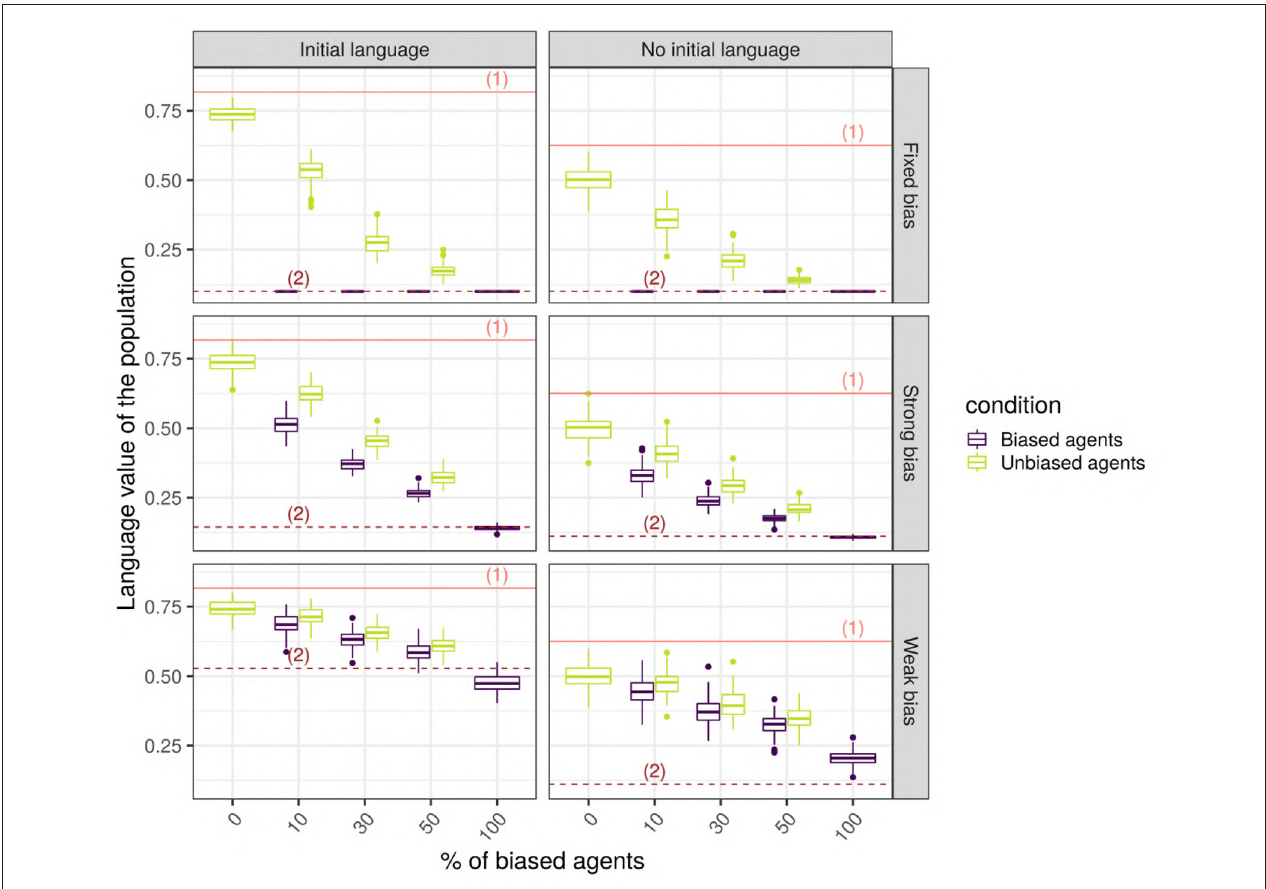
FIGURE 9 | The final language value of the whole population for a scale-free network with 150 SAM agents. The solid line (1) shows the initial value of the language for the unbiased agents, while the dotted lines (2) show the initial value of the language for biased agents. The horizontal axis shows the different cases considered (combinations of bias strength and proportion of biased agents in the populations), the vertical axis is the language value of the population, and the colored boxplots show the distribution of the language values among the biased (blue) and unbiased (green)